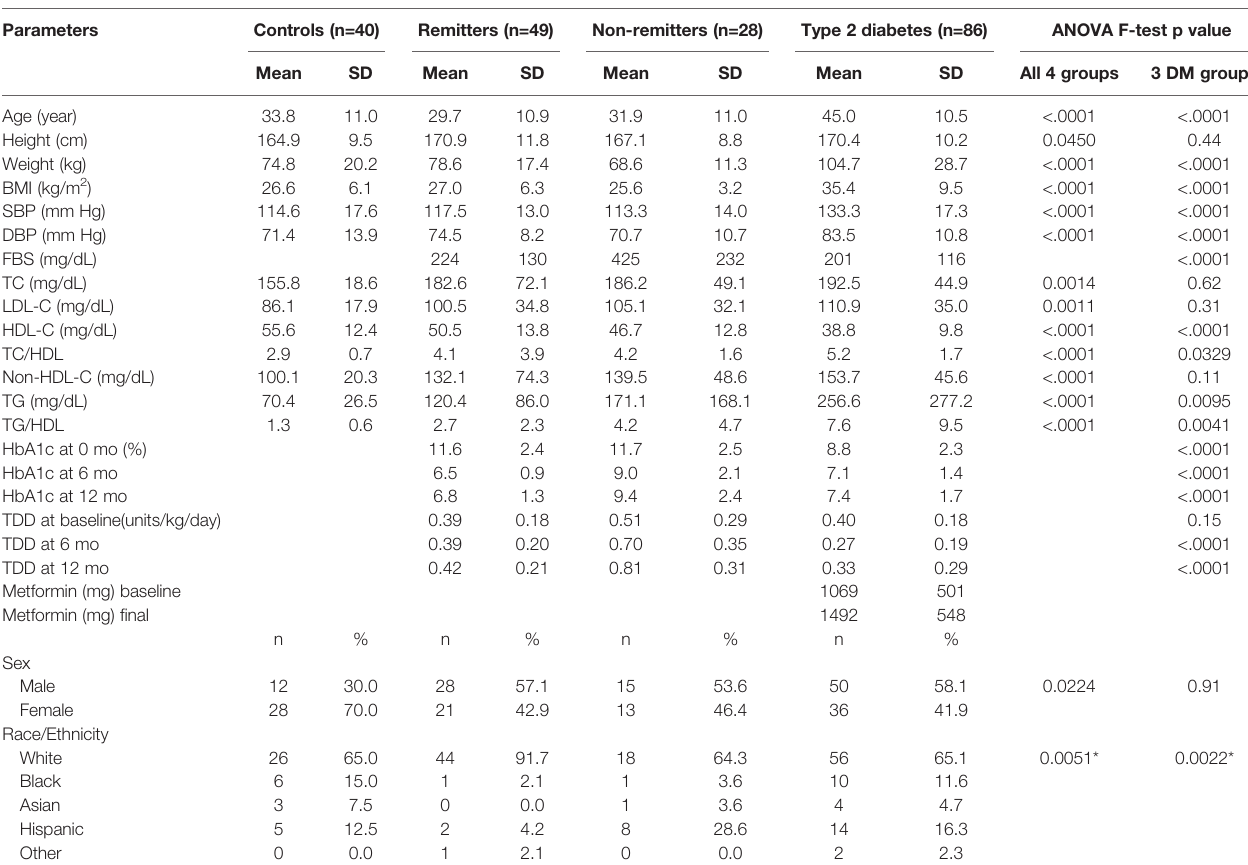
TABLE 2 | Comparison of anthropometric, biochemical, and therapeutic parameters (5) .